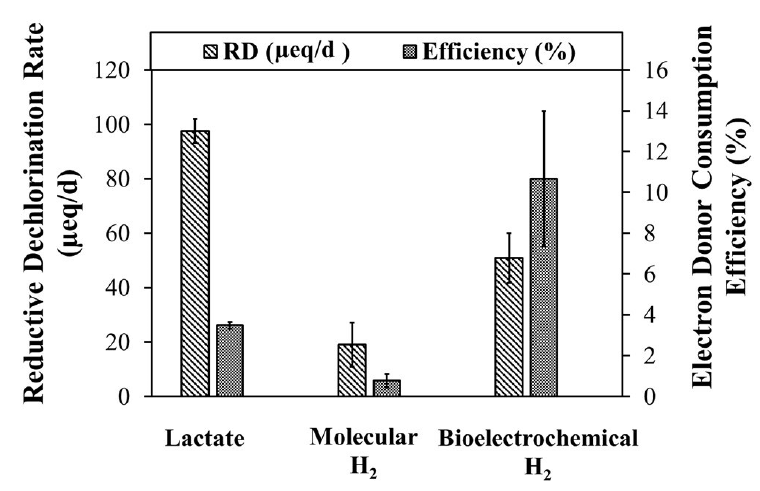
Figure 7. RD reaction rate and percentage efficiency of the electron donor consumption for the in- vestigated